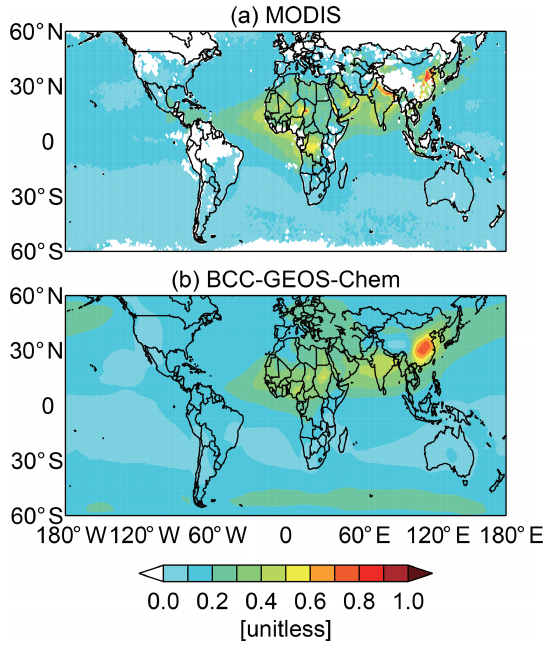
Figure 11. Spatial distributions of annual mean aerosol optical depth (AOD) at 550nm from (a) MODIS satellite observations and (b) BCC-GEOS-Chem v1.0 averaged over